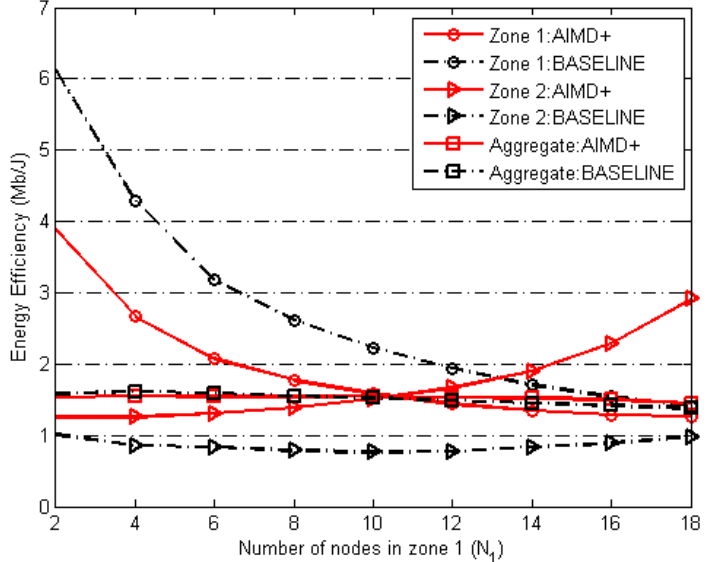
Figure 11. Comparison of additive increase, multiplicative decrease (AIMD+) with